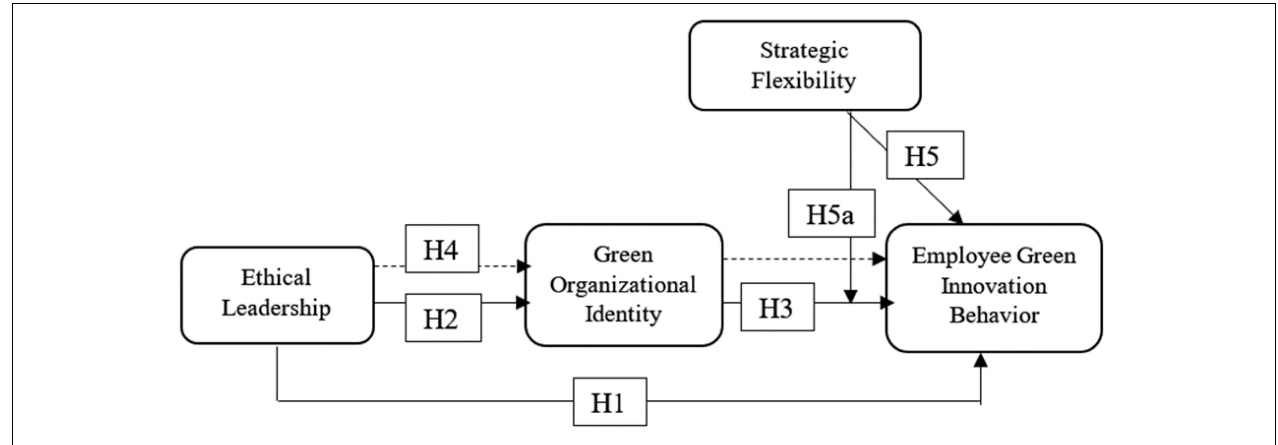
FIGURE 1 | Research